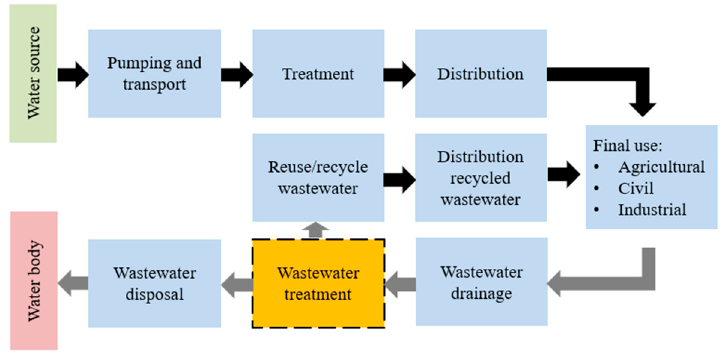
Figure 1. Water management cycle: process diagram (adapted from [22]).